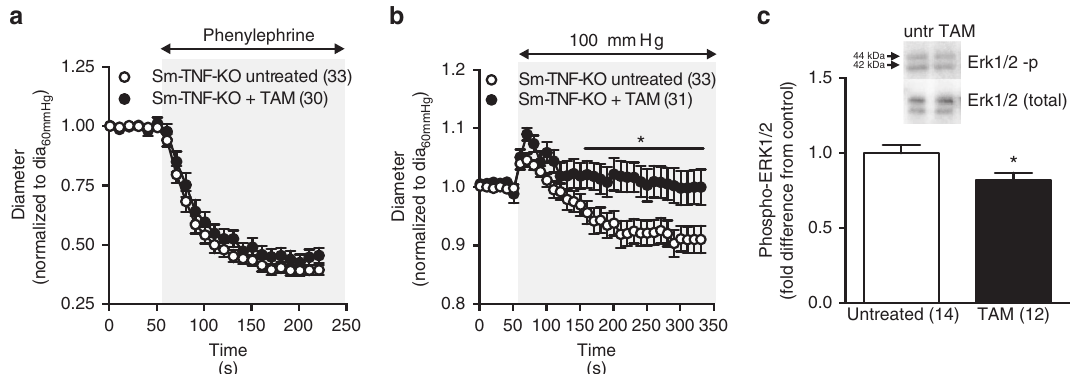
Figure 5 | Pressure-induced ERK phosphorylation after smooth muscle Tnf deletion. Cremaster muscle arteries were excised from tamoxifen treatment (TAM, 1mgday (cid:2) 1 for 3 days) in Sm-TNF-KO mice and untreated controls. ( a ) Phenylephrine-induced (10 m moll (cid:2) 1 , grey shading) vasoconstriction in cremaster arteries isolated from untreated and TAM-treated Sm-TNF-KO mice. ( b ) Diameter changes in response to a single-step increase in transmural pressure (60–100mmHg, grey shading). ( c ) phospho-ERK1/2 levels in cremaster arteries isolated from untreated and TAM-treated Sm-TNF KO mice (normalized to total ERK1/2, expressed as fold-difference from untreated controls on same blot). Inset: representative western blot. Two arteries were pooled for each sample, and densitometry reflects 12–14 samples per group on five separate blots. Uncropped western blot images are shown in Supplementary Fig. 5. Numbers in parentheses indicate number of arteries per group ( a , b ) and number of replicates per group ( c ). Data are mean ± s.e.m. * P o 0.05 in an unpaired Student’s t -test. ANOVA, analysis of